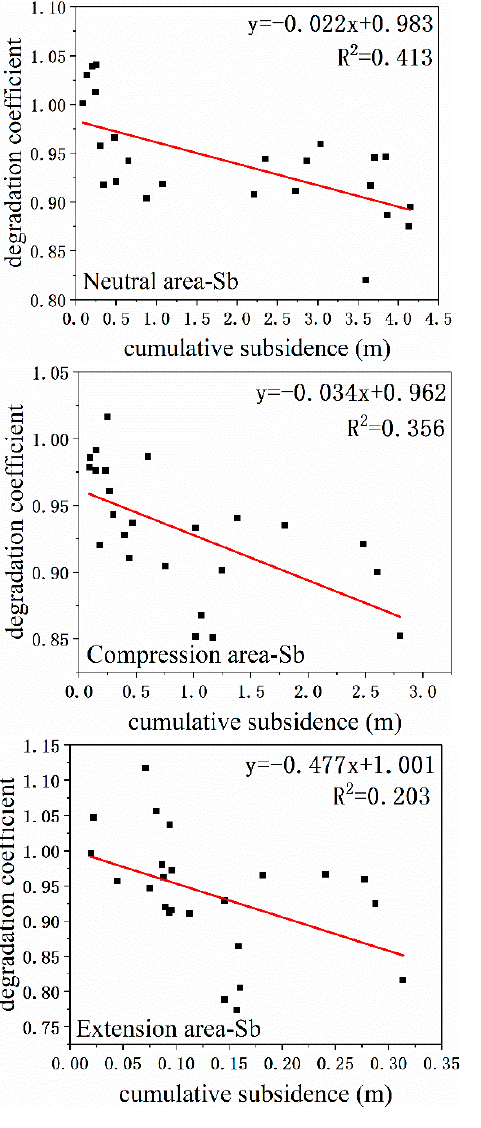
Figure 7. Relationship between degradation coefficient and ground subsidence at leaf scale. Source: Built on the basis of the author’s calculations.